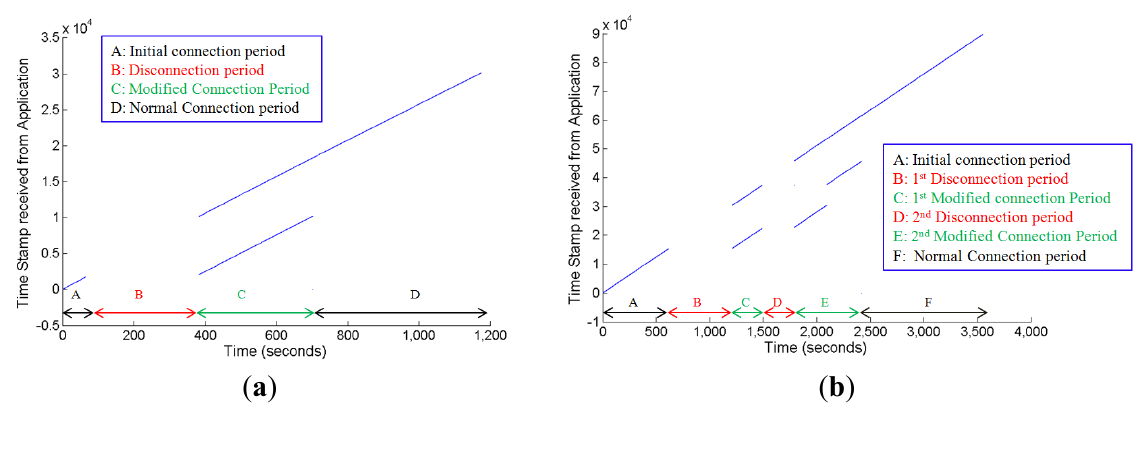
Figure 6. Scatter plots for the formal test of the data retention scheme: ( a ) single disconnection; ( b ) multiple